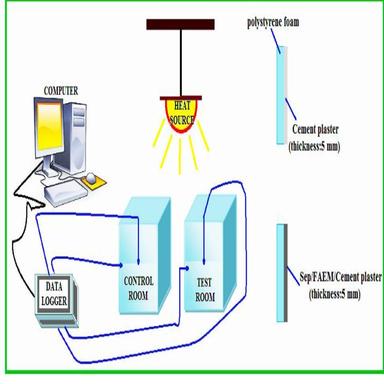
The experimental set-up for establishment of temperature control performance of Sep/FAEM/Cement plaster.